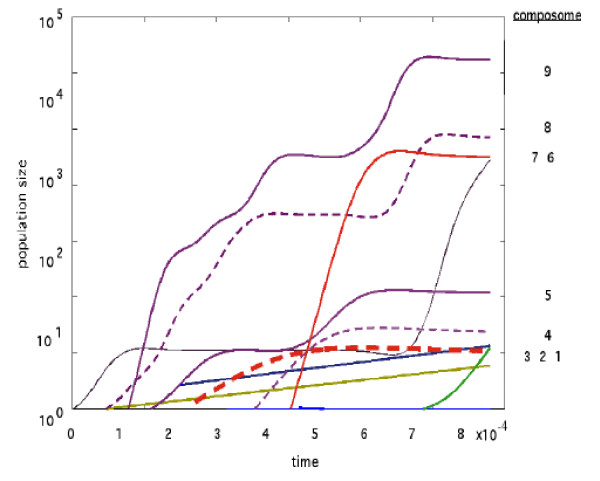
C-GARD population dynamics emulating the competitive coexistence of composomes. The time dependent population sizes for the different composomes were reconstructed in an approximated fashion from single assembly simulations as described in the text. Simulation parameters are as in Figure 3.